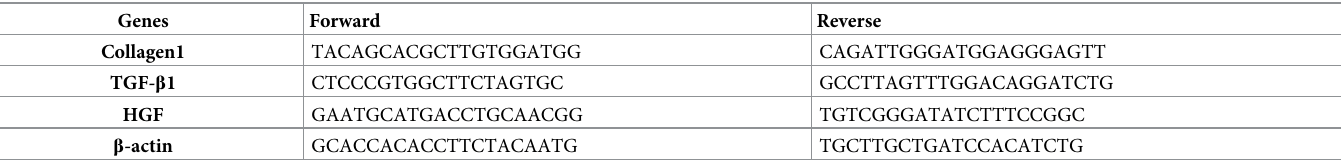
Table 1. Primers used in real-time PCR.